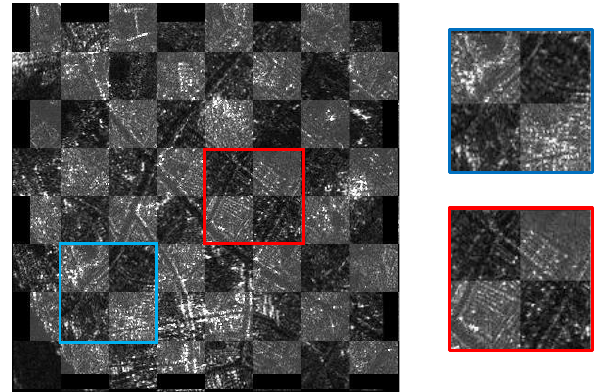
Figure 9. The Chessboard Diagram for Wuhan